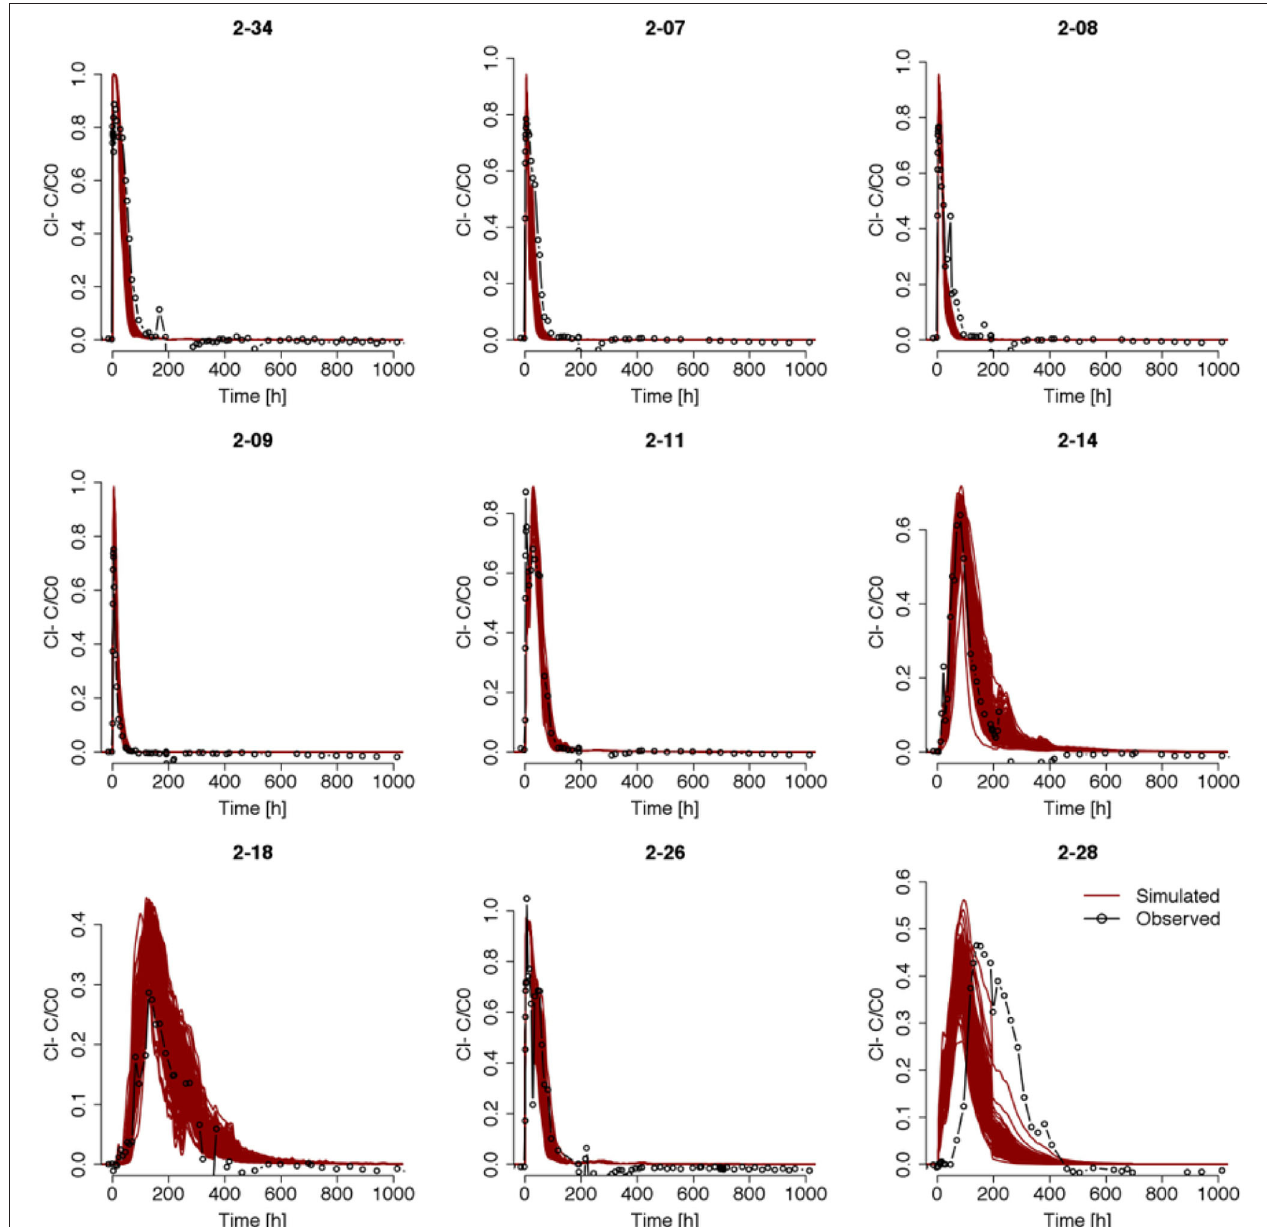
FIGURE 6 | Posterior ensemble of tracer breakthrough curves in selected wells after three iterations of iterative ensemble smoother. The plotting specifics are the same as those given in Figure 5 .